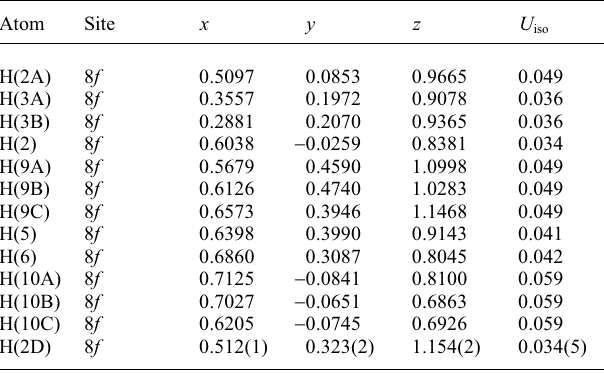
Table 2. Atomic coordinates and displacement parameters (in Å 2 )